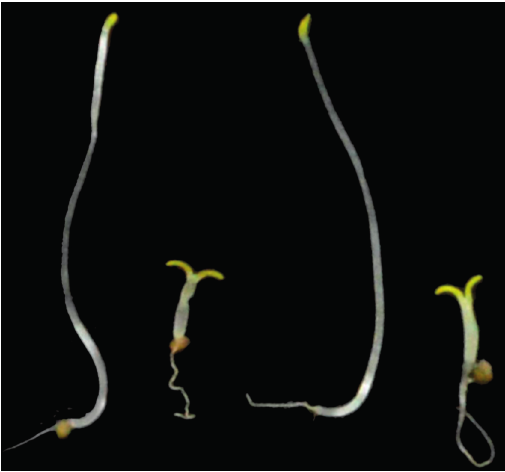
Figure 4. Responses of Arabidopsis seedlings to FM treatments and BL and GA complementation. All of the plants were grown on ½ MS media without chemical treatment in the dark for five days. Plants shown are as follows: wild-type plant without FM treatment (the plant on the left); plant grown on ½ MS media containing 10 μ M FM (the second plant from the left); plant treated with 10 μ M FM and 10 nM BL (second plant from the right); and wild-type plant grown on ½ MS media containing 10 μ M FM and 1 μ M GA (the plant on the right). Experiments were performed in triplicate to establish